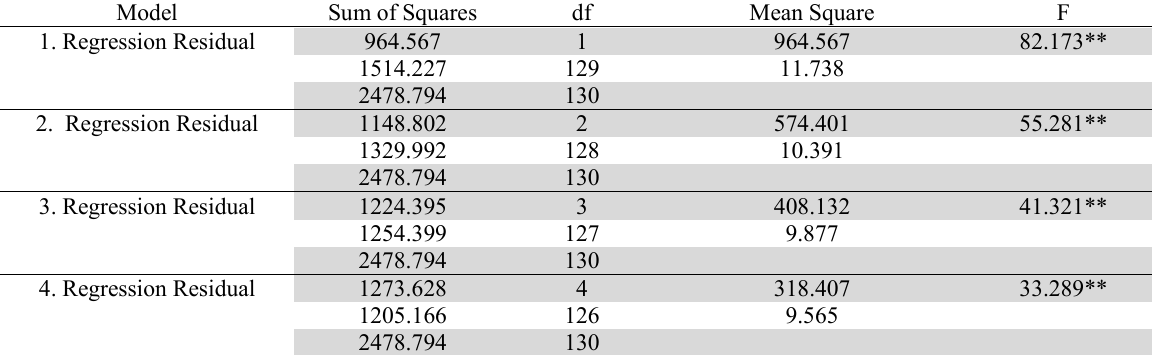
ANOVA of multiple regressions of various facets of work-life balance with personal needs among dairy